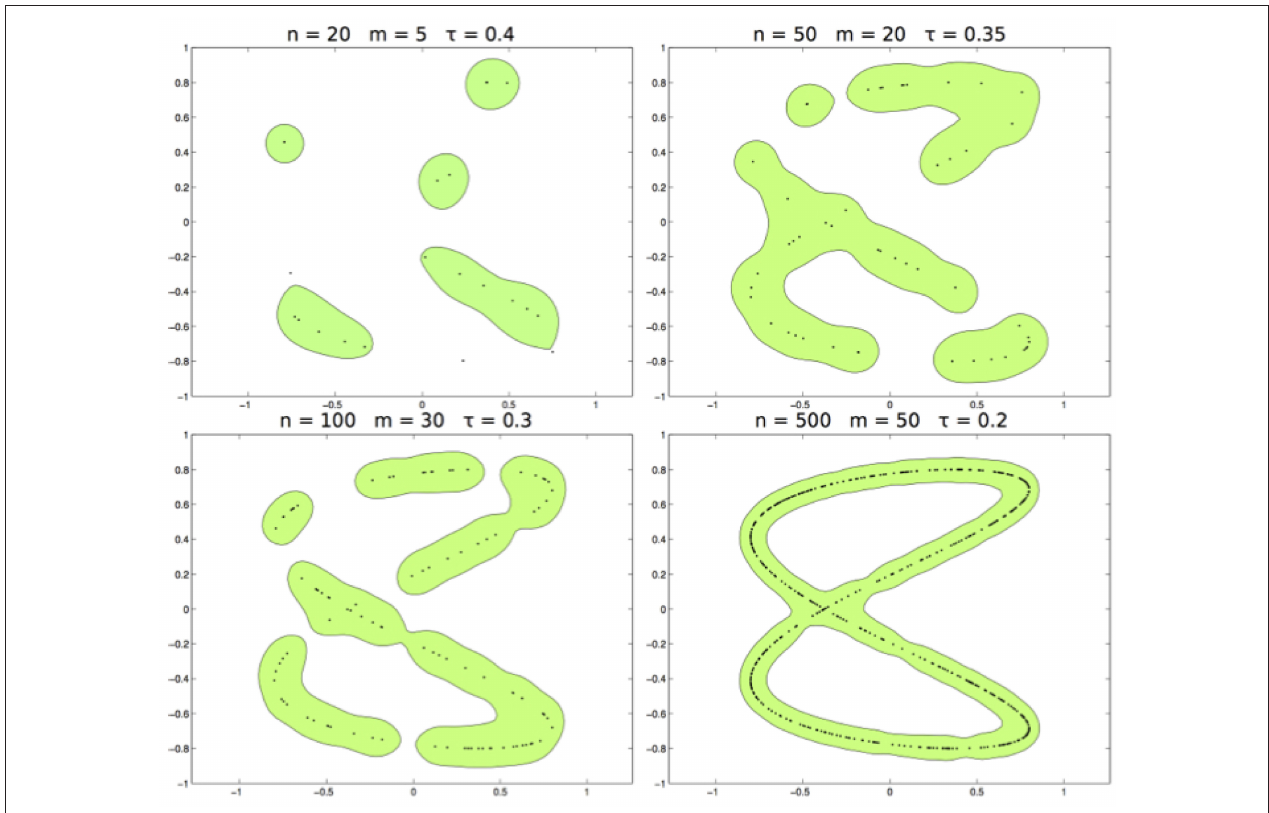
FIGURE 5 | From left to right and top to bottom. The learned set ˆ C m , τ n with n respectively of 20,50,100,500, and m